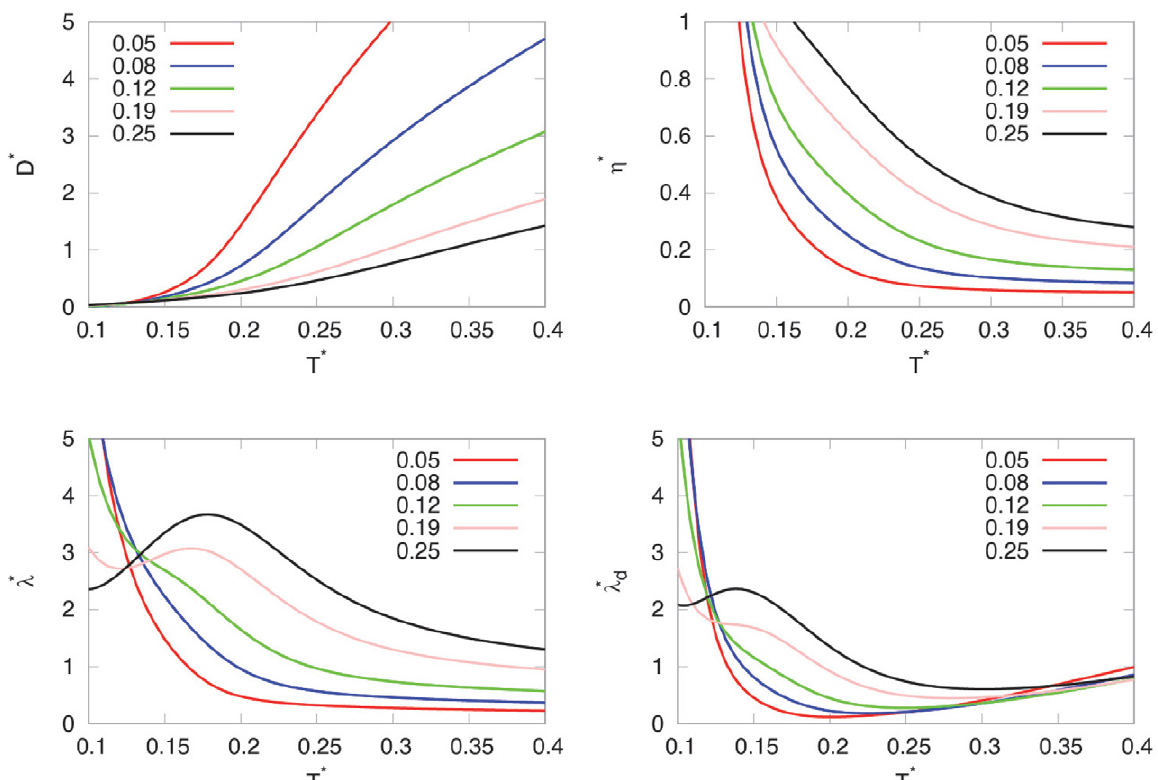
Figure 9: Temperature dependence of the diffusion ( D * ), viscosity ( h * ), thermal conductivity ( l * ) and thermal diffusivity ( l d* ) for 2D MB water for different pressures calculated by the theory.